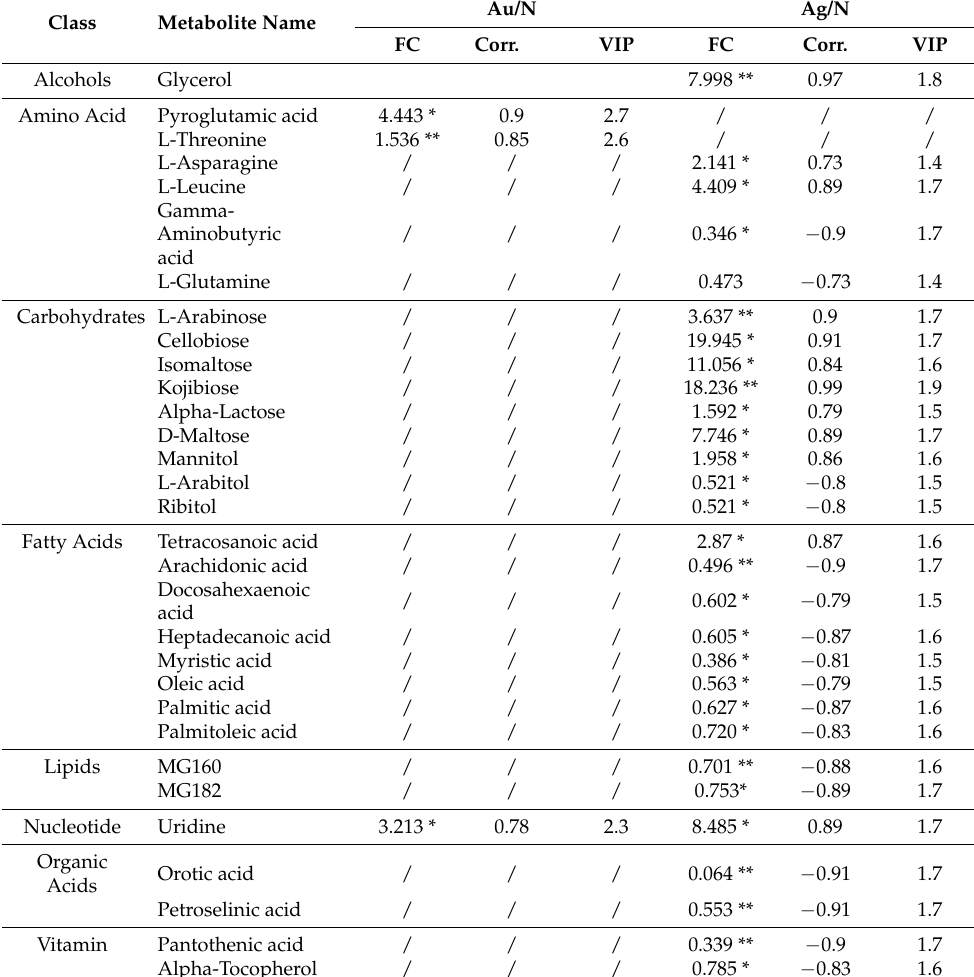
Table 1. Significantly changed metabolites in liver induced by AuNRs or Au@Ag NRs at 2 w. Metabolites were identified by performing PLS-DA analysis and t test between nanorod-treated groups and control group ( n = 3 or 4) using XploreMET software. * p < 0.05 and ** p < 0.01 identified by Student’s t test, comparting to controls, respectively. The fold change (FC) was obtained by comparing relevant metabolites in the nanorod groups with the control group. Corr., correlation coefficients; VIP, variable importance in